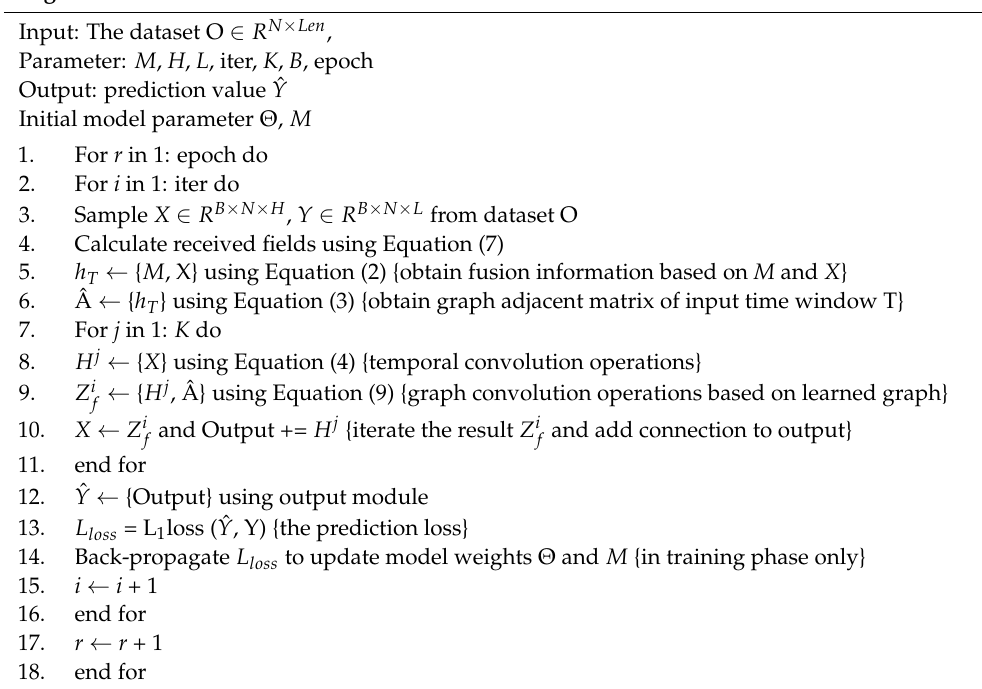
Algorithm 1: General Framework for